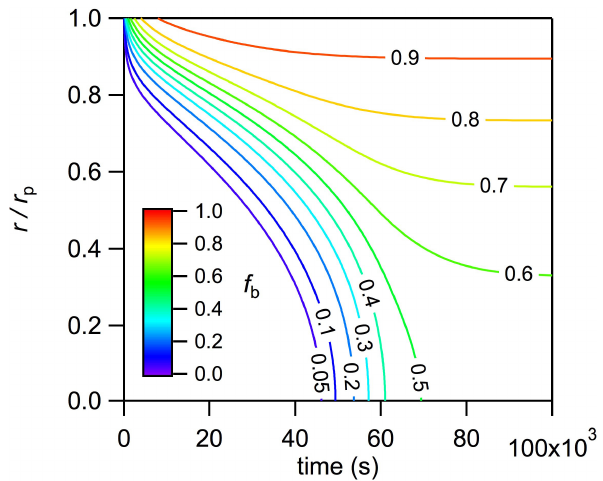
Fig. 6. Extent of solidification in the particle bulk, f b , as a function of time and depth in the 275nm-radius